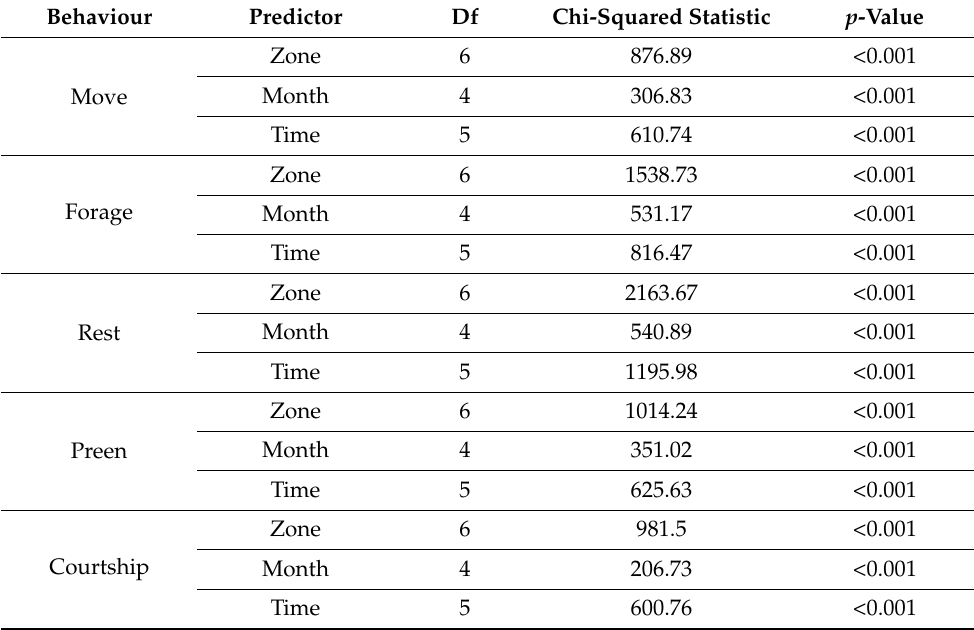
Figure 3. The percentage of outside observations (out of all observations) of flamingos performing five state behaviours within each enclosure zone at different times of the day. Table 4. Wald’s Chi-squared tests from Poisson regression on lesser flamingo behaviour for different times of day, different enclosure zones and different months.